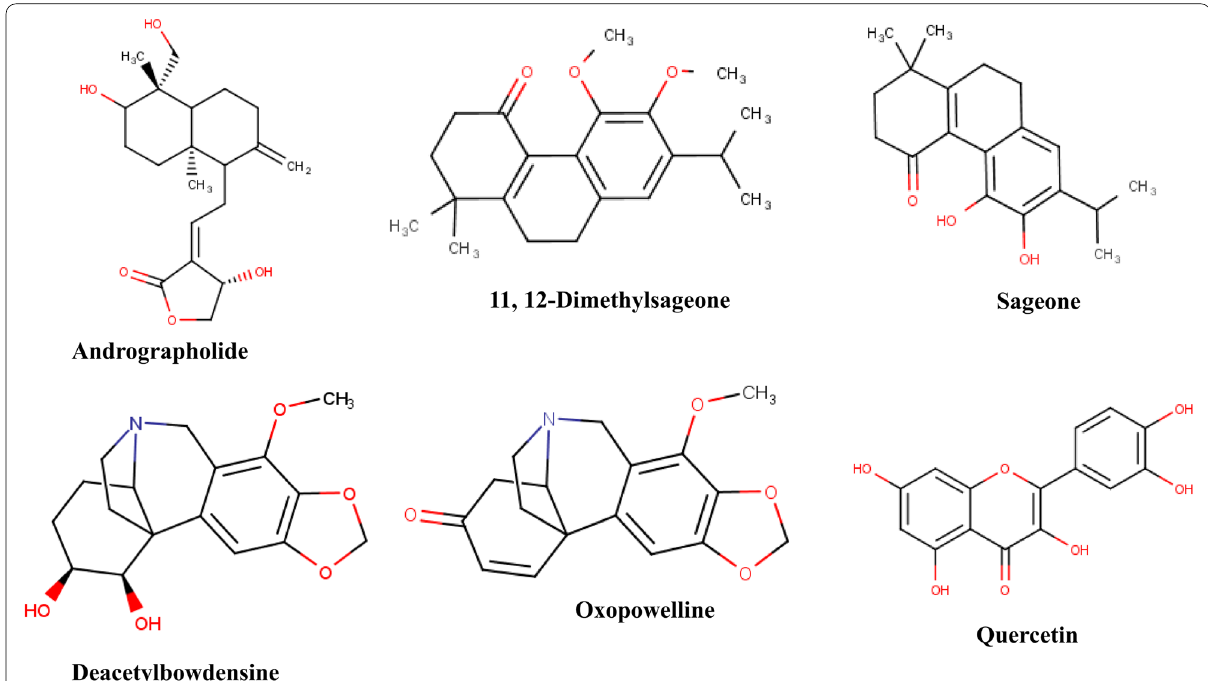
Fig. 4 2D structure of 6 hit phytocompounds with a high binding